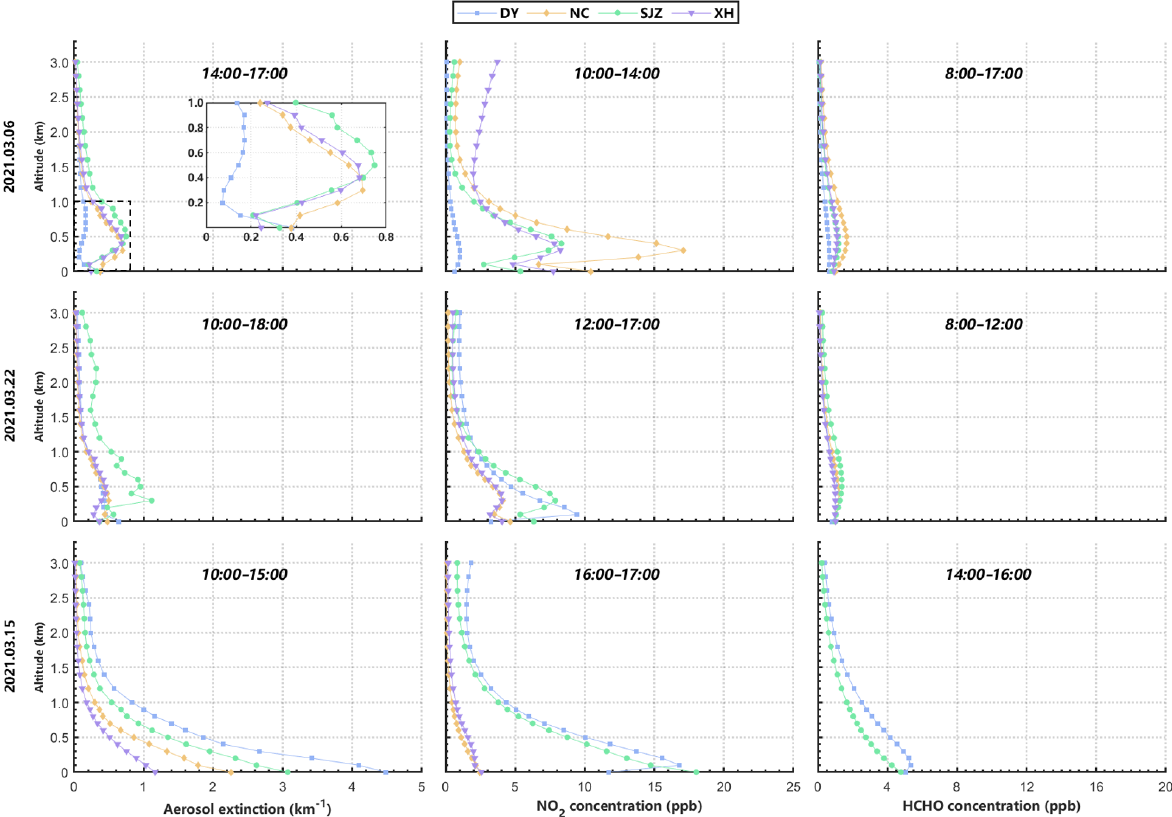
Figure 6. The daily averaged vertical profiles of AECs (left), NO 2 (middle), and HCHO (right) at DY, NC, SJZ, and XH stations during two clean days (6 and 22 March 2021) and one dusty day (15 March 2021). The upper annotation in each subplot represents their corresponding time periods, during which each station generated the greatest amount of data as